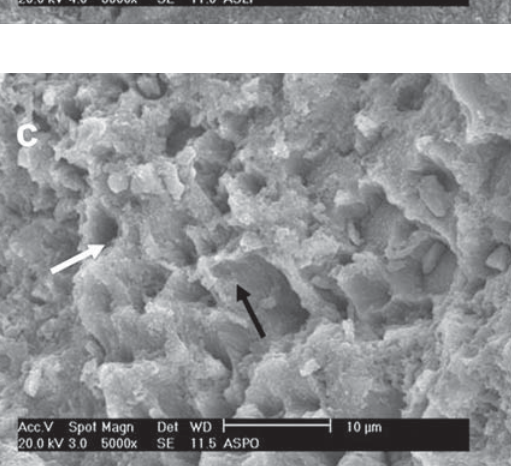
FIGURE 5- SEM micrograph of different enamel treated- groups following treatment with AdheSe self-etching primer. a - Prophylaxis: The surface is predominantly smooth (white arrow) with areas of shallow and wide depressions (black arrow); b – SiC paper: The demineralization pattern is not uniform (black arrow). Areas with deep and narrow depressions can be seen (white arrow); c – Diamond bur: Enamel rods (black arrow) and a Type I etching pattern (white arrow) can be identified